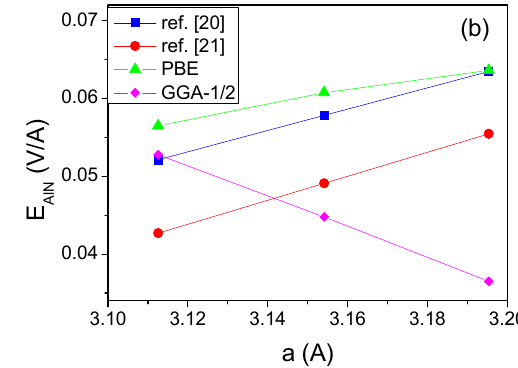
Figure 5. Electric fields in the well ( a ) and barrier ( b ) in 8AlN-8GaN atomic layers superlattice for various values of a lattice parameter a . The data denoted as refs. [20,21] were calculated using the values listed in Table 1 via Equation (3); the data denoted PBE and GGA-1/2 were obtained from ab initio electric potential using these two approximations.